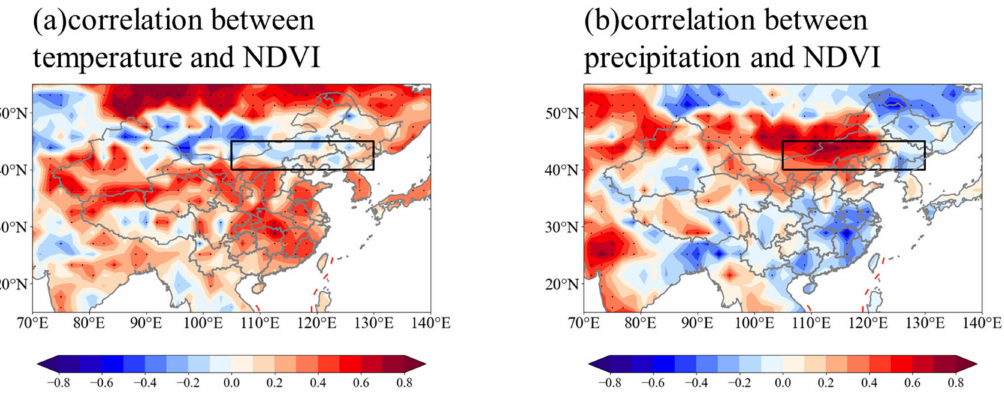
Figure 9. Spatial correlations (grid-to-grid correlation) between NDVI and average temperature ( ◦ C) ( a ) and average precipitation (mm) ( b ). Note: red color represents positive correlation, and blue color represents negative correlation. The red dashed lines in the figure represent Ten-dashed lines. The numbers below the description of the colors represent the spatial correlation coefficients. The black box in it is defined as the northeastern region of East Asia (40~45 ◦ N, 105~130 ◦ E). Note: dots represent correlations significance at p < 0.1, and in the dotted areas, the effective degree of freedom varies spatially between 26–30.